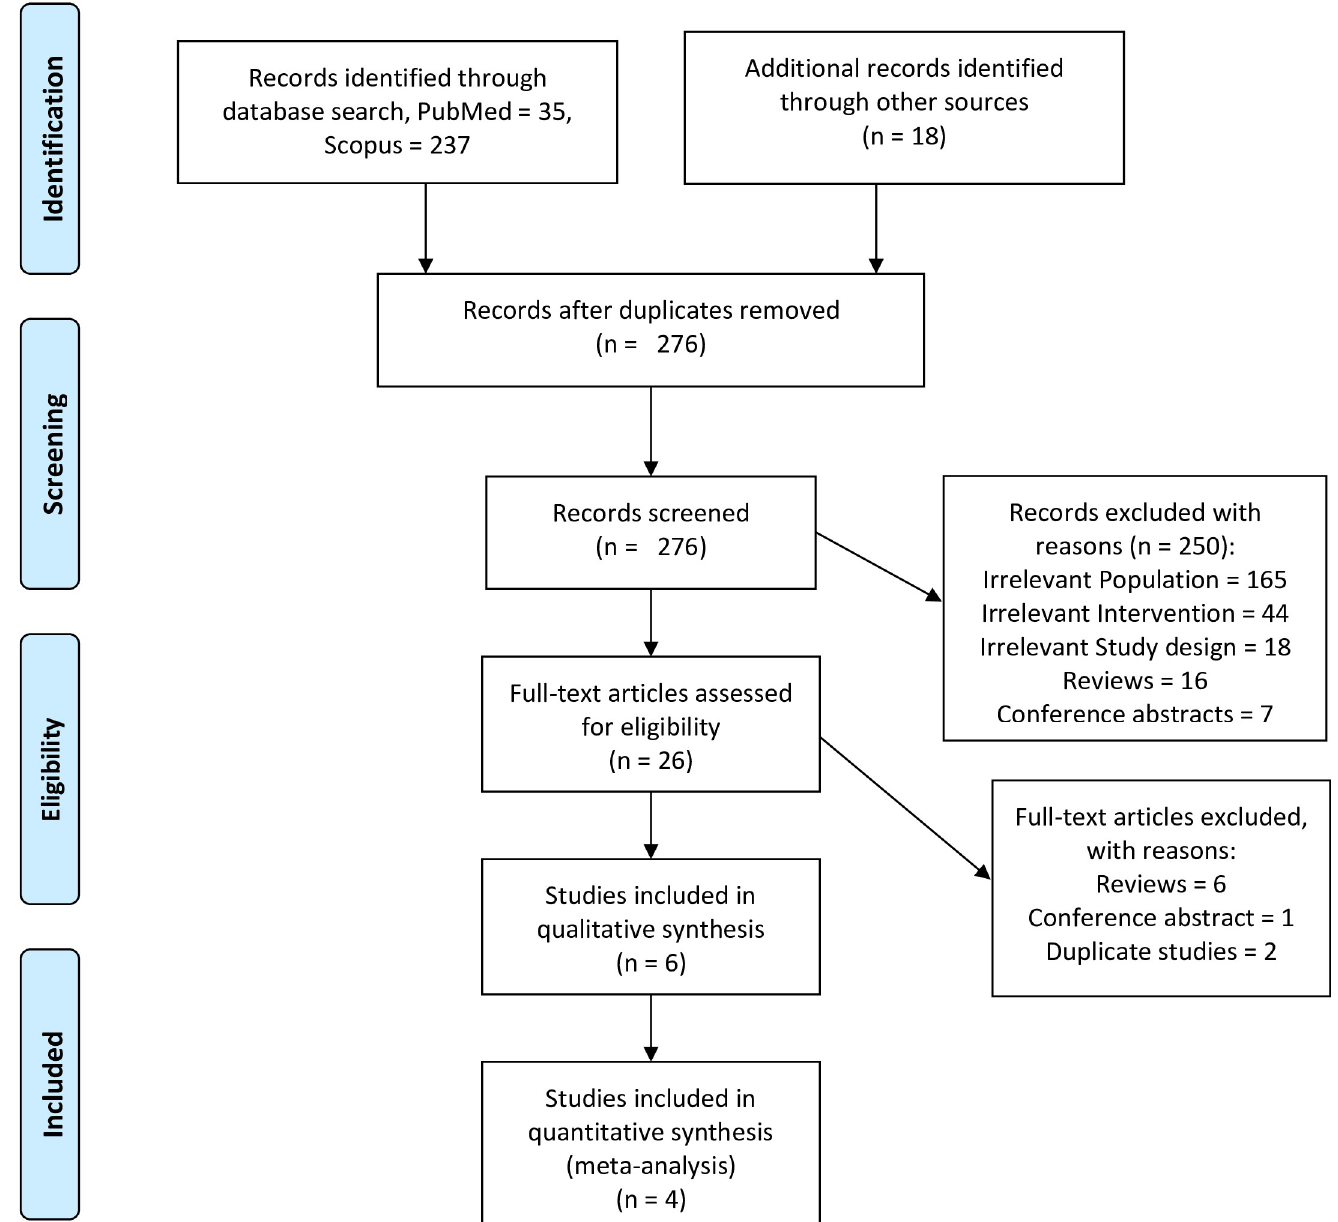
Fig 1. PRISMA flow